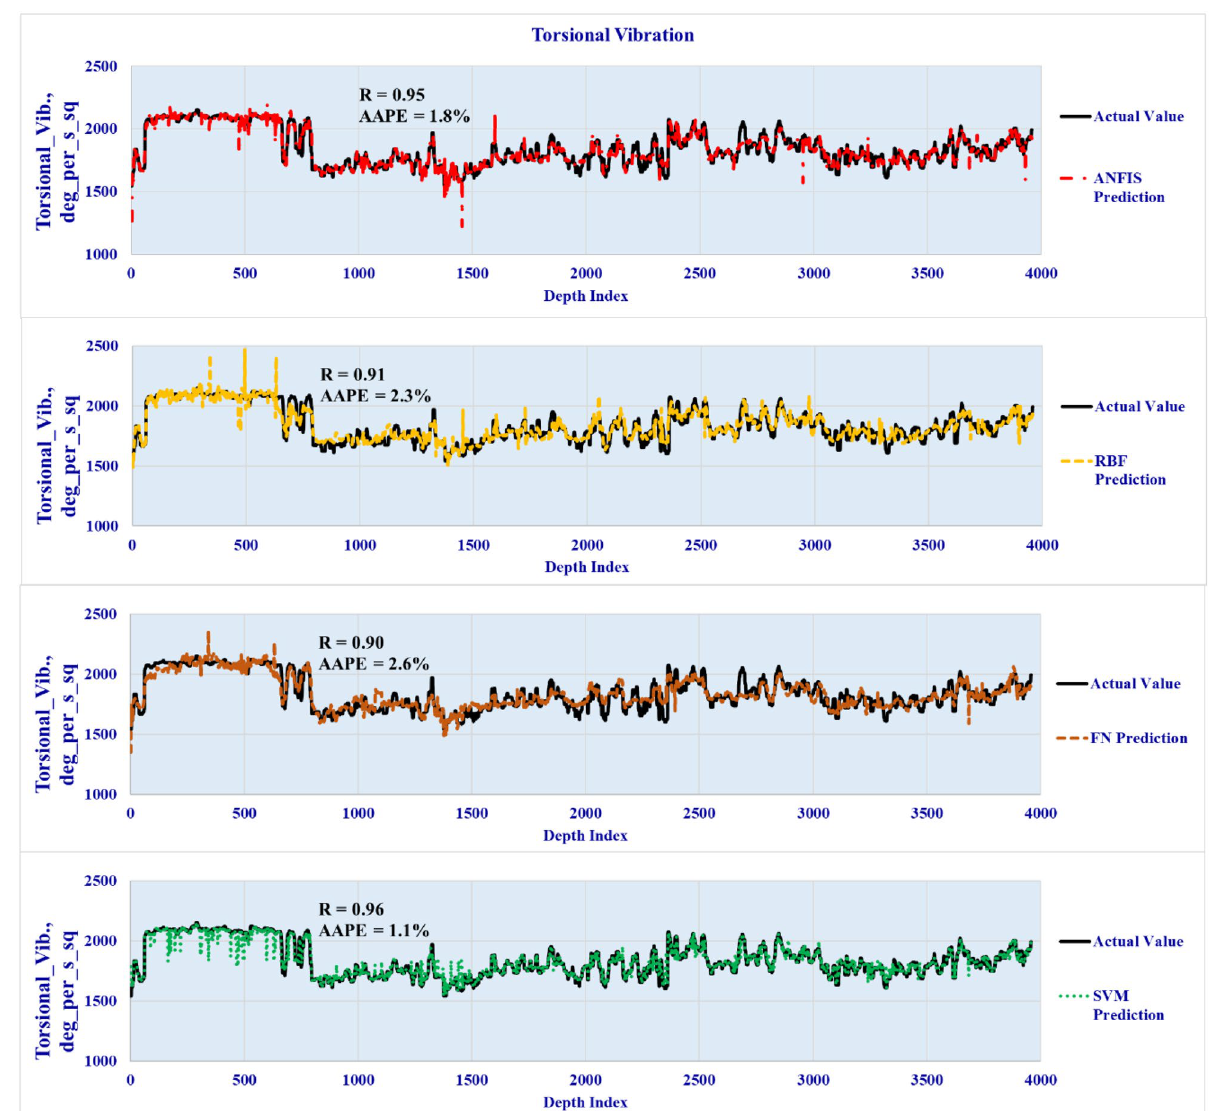
Figure 9. Torsional vibration prediction results (Validation well data